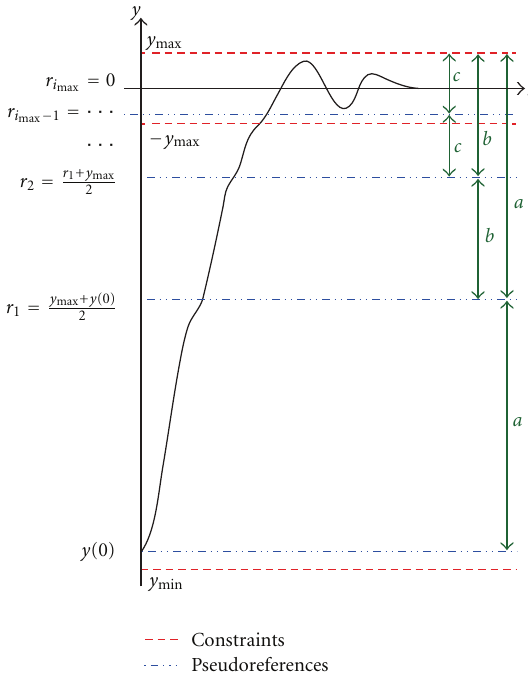
Figure 2: Illustration of the proposed pseudoreference scheme.